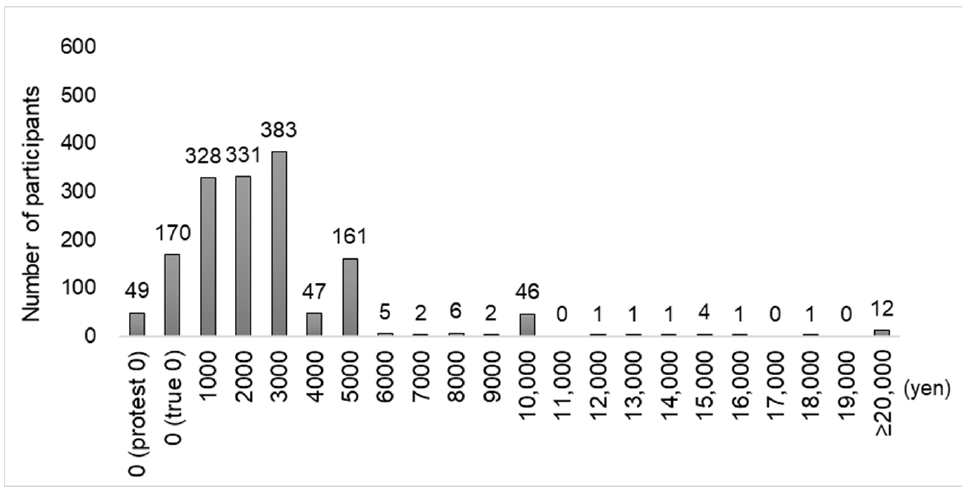
Figure 2. Distribution of WTP values for dental checkups in the non-RDC group.